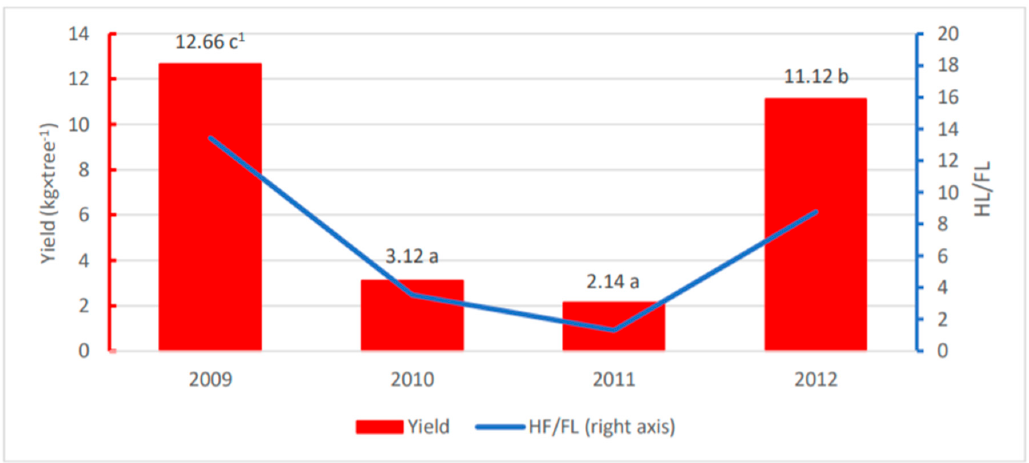
Figure 3. Mean yields of ‘Regina’ sweet cherry trees in 2009–2012 and percentage of harvested fruit to the number of flowers ratio (HF/FL). 1 one-way analyses of variance; data in bars marked with the same letter are not significantly different at α = 0.05 (Duncan’s test).